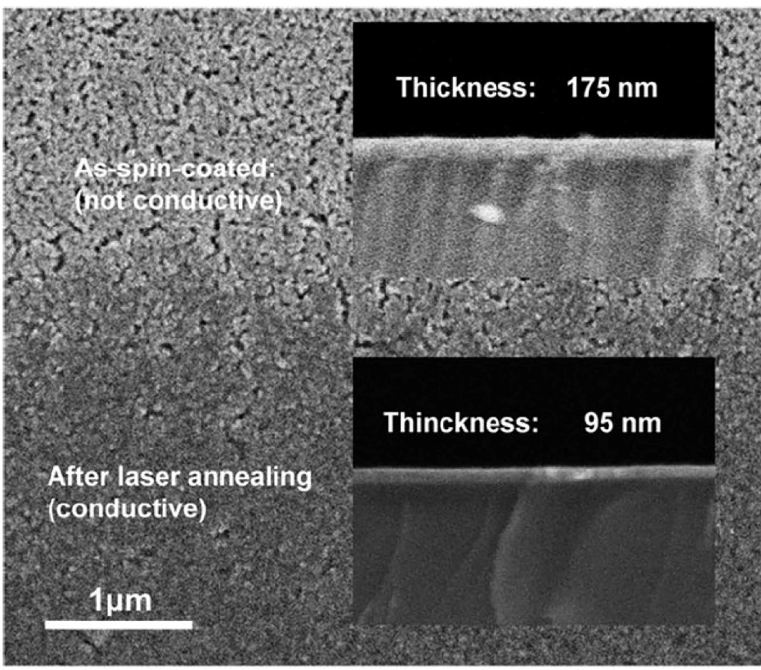
Figure 6. SEM images of ZnO films before and after laser treatment [73].